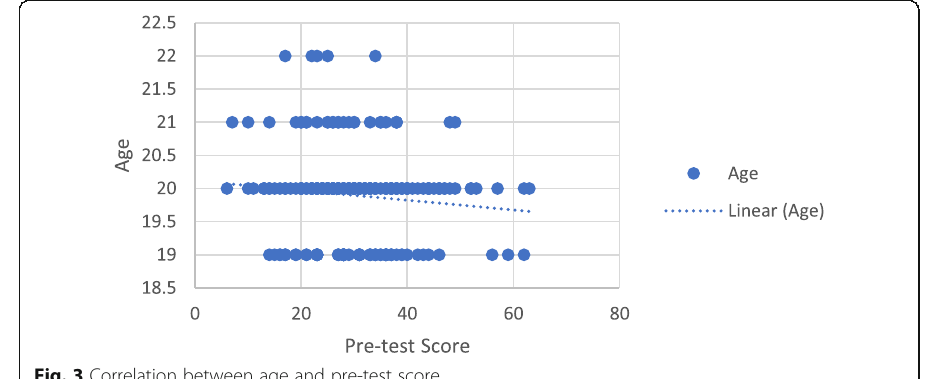
Fig. 3 Correlation between age and pre-test score